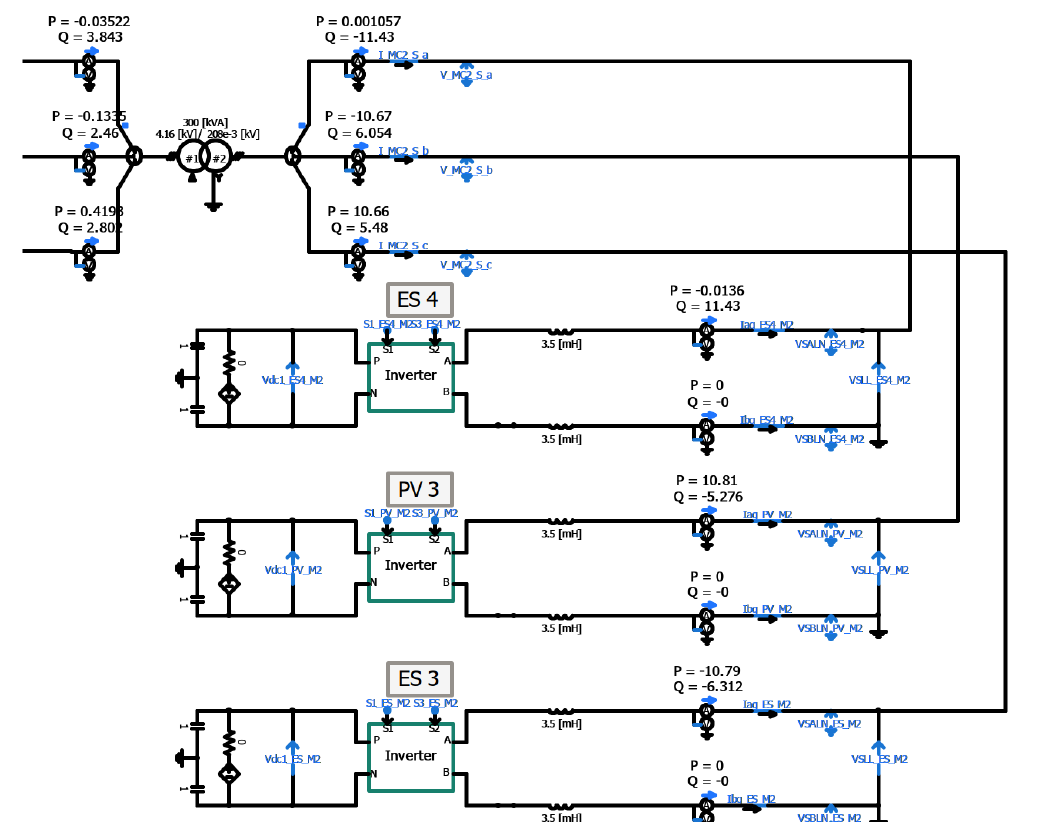
Figure 18. PSCAD simulation shows the active and reactive power flow (in kW and kvar) of Microgrid 2 after the first power routing action. 10 kW from phase B is routed to C at the secondary circuit. The active and reactive power required for IPPF control are provided solely from the secondary